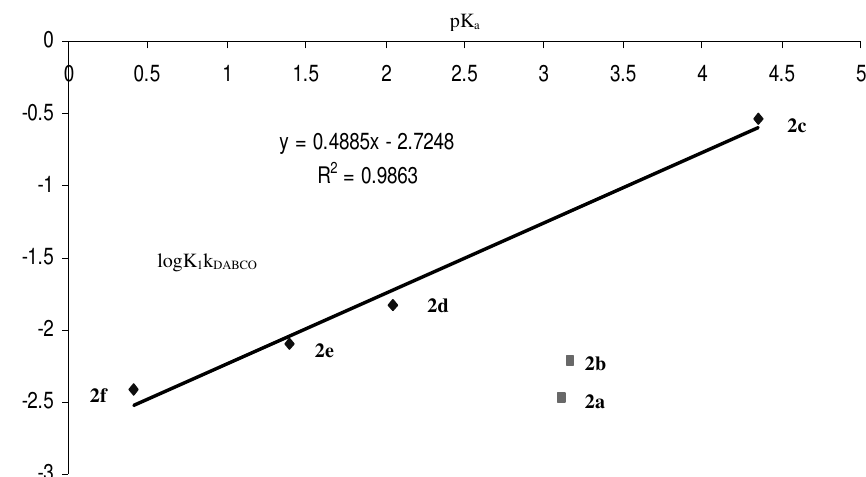
Figure 1. Plot of log K k for the reaction of 1 with anilines versus the pK 1 DABCO the corresponding anilinium ions. ( The slope is 0.50. Points a, b, c, d, e and f, represent 2,6- Et, 2,6-Me, 2,4-Me, 2-F, 2-Cl, 2-CN-anilines respectively ). y = 0.555x - 2.0704 R 2 = 0.9678